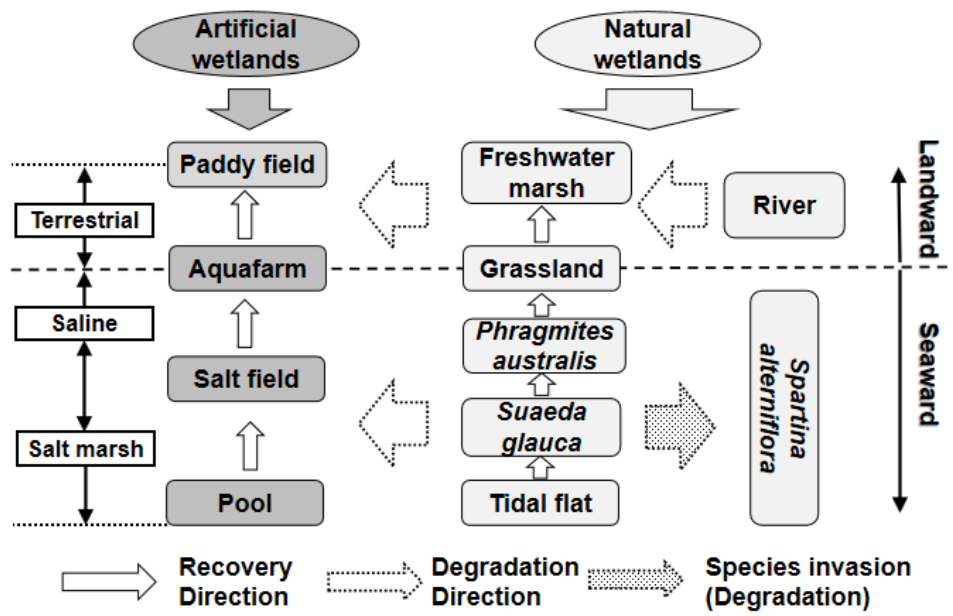
Figure 3. Directional succession model of the coastal wetland landscape in northern Jiangsu, China.